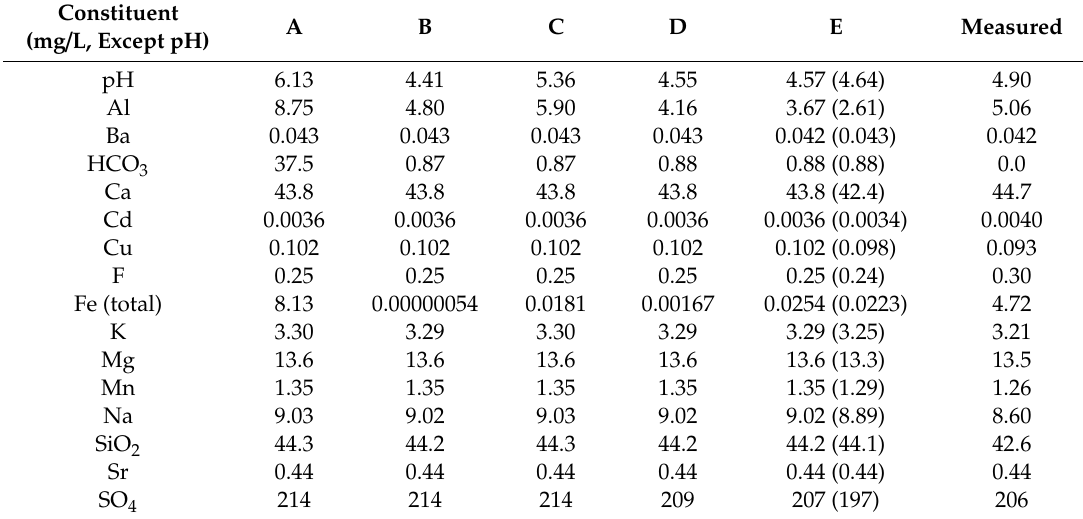
Table 2. Results of simulations resulting from mixing and reaction (see text for